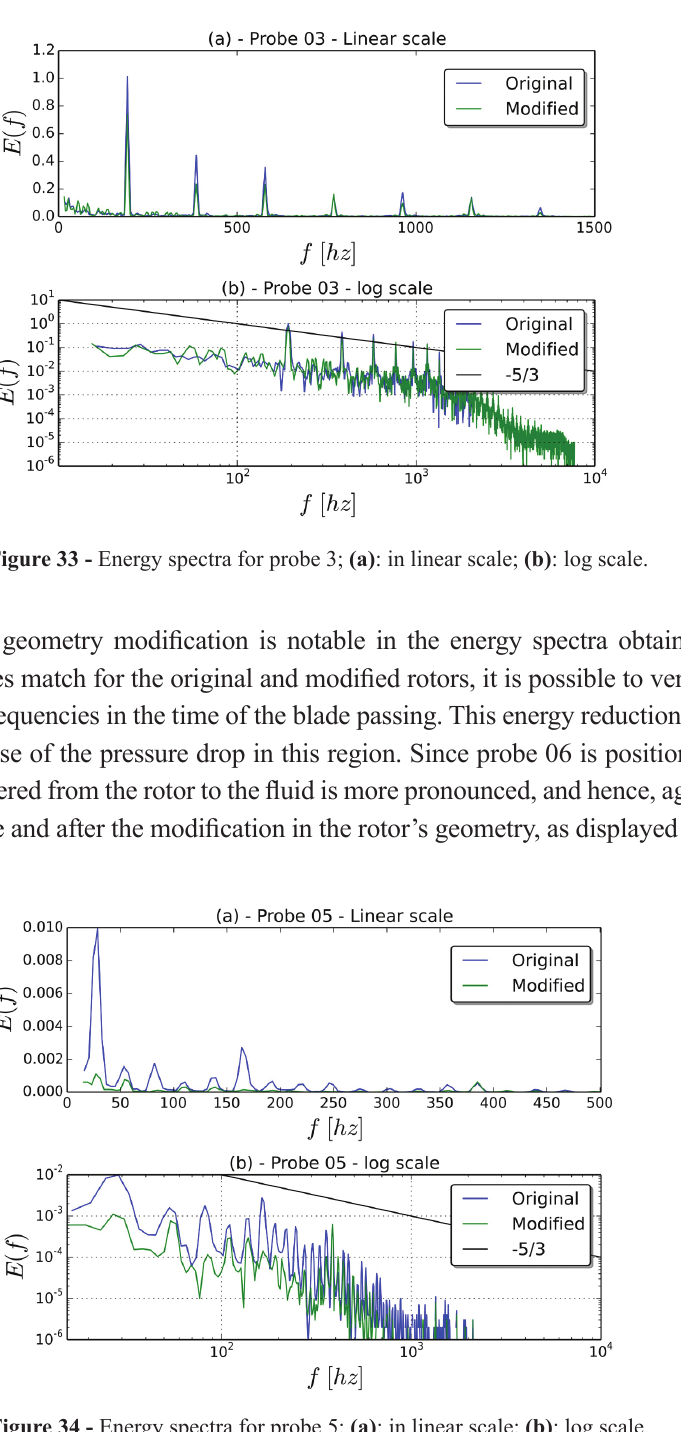
Figure 34 - Energy spectra for probe 5; (a) : in linear scale; (b) : log